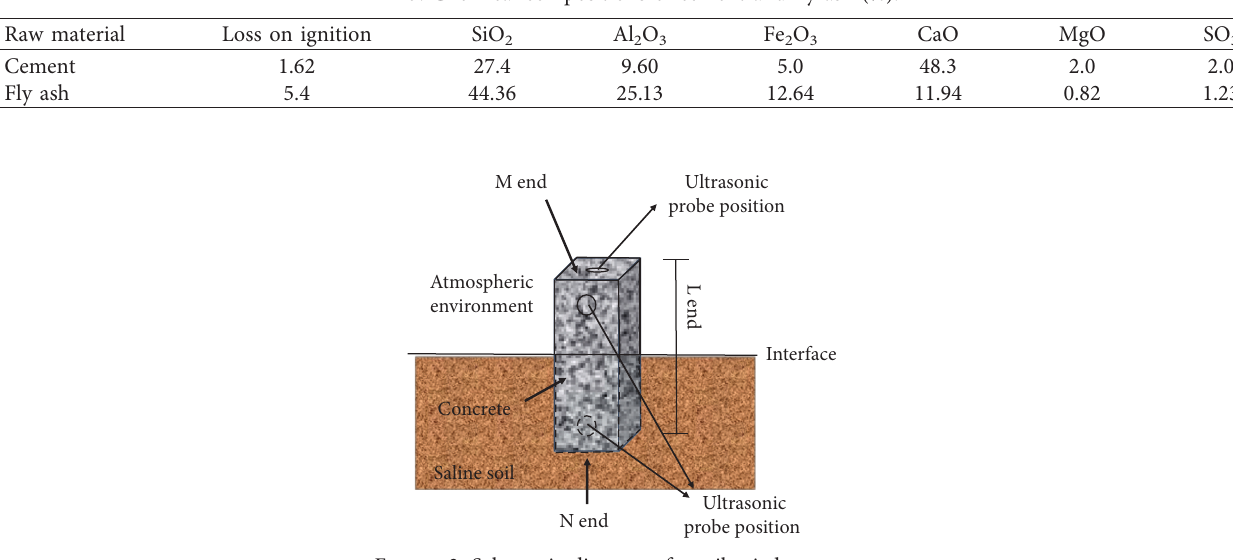
Table 3: Chemical compositions of cement and fly ash (%).